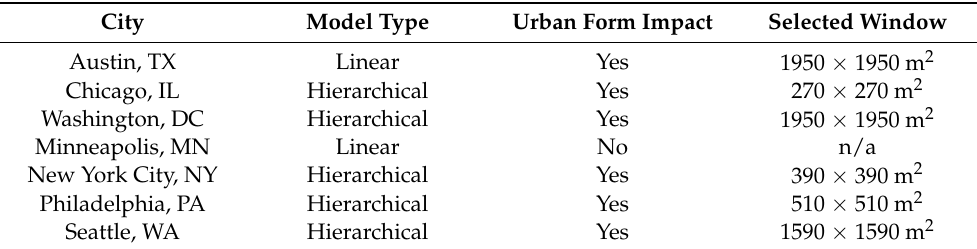
Table 2. Significance of urban form variables’ impact on energy